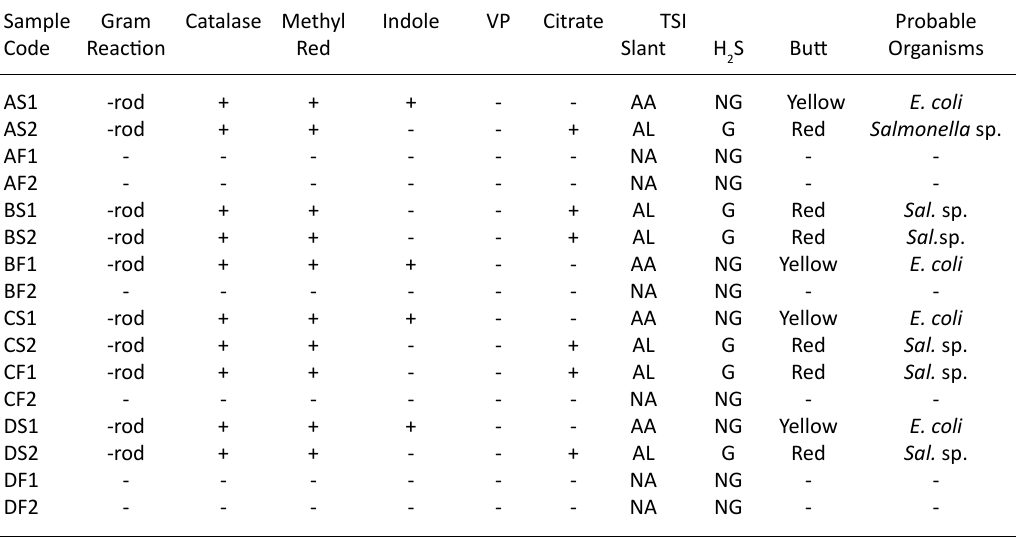
table 3. Characterization and Identification of Bacterial Isolates from Chicken Feeds Sample